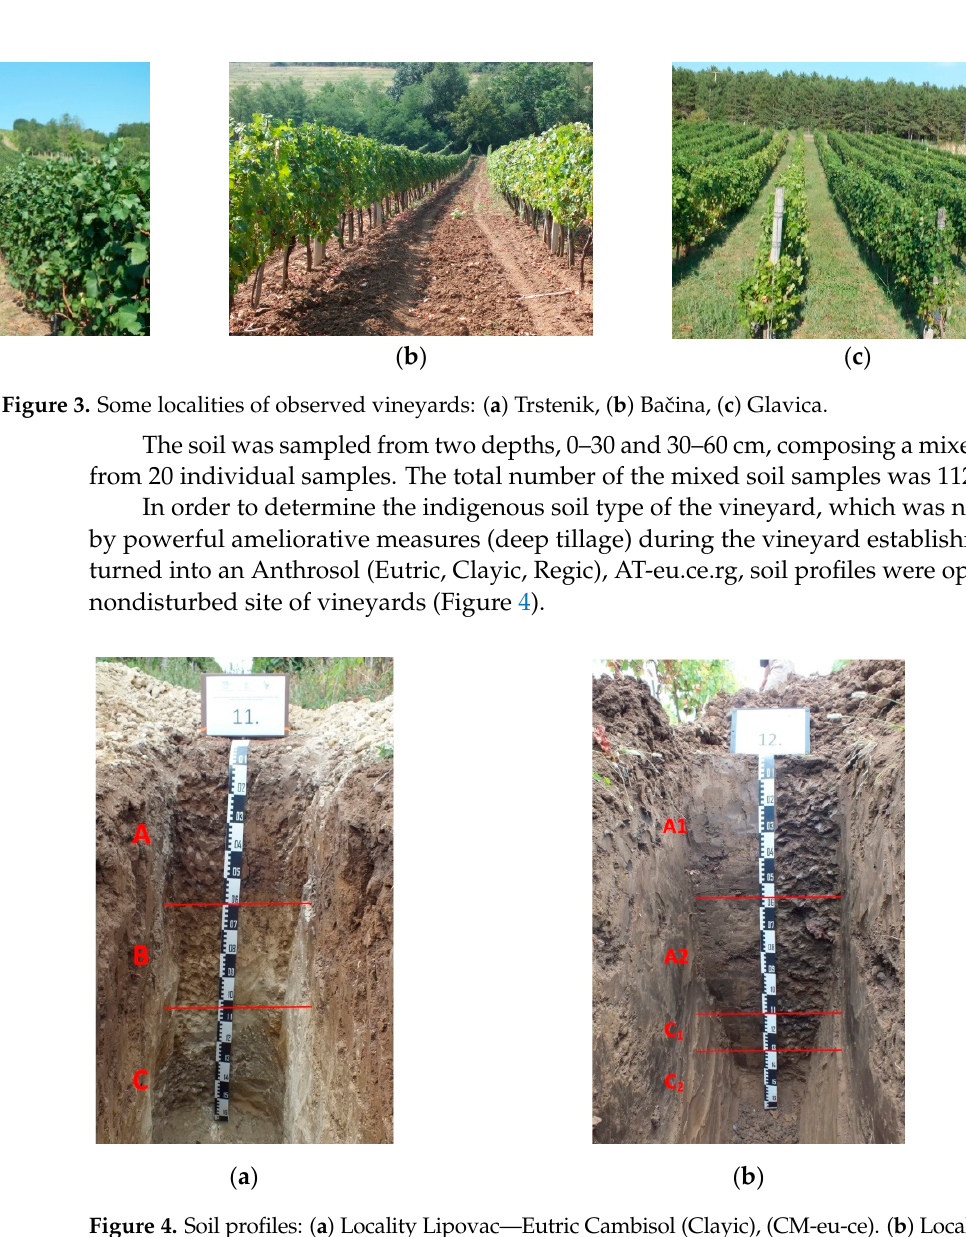
( B ) Figure 2. ( A ) Pedological map of the Tri Morave vineyard region and borders of vine growing districts, according the World Reference Base (WRB) soil classification, based on digitalized primary pedological map of the Republic of Serbia 1: 50,000. ( B ) Geomorphological map (1—alluvial plains, 2—dissected fluvial terraces in the zone of low hills, 3—mountain relief zone, 4—borders of the Tri Morava vineyard region, 5—a smaller river valley, 6—paleomeander).